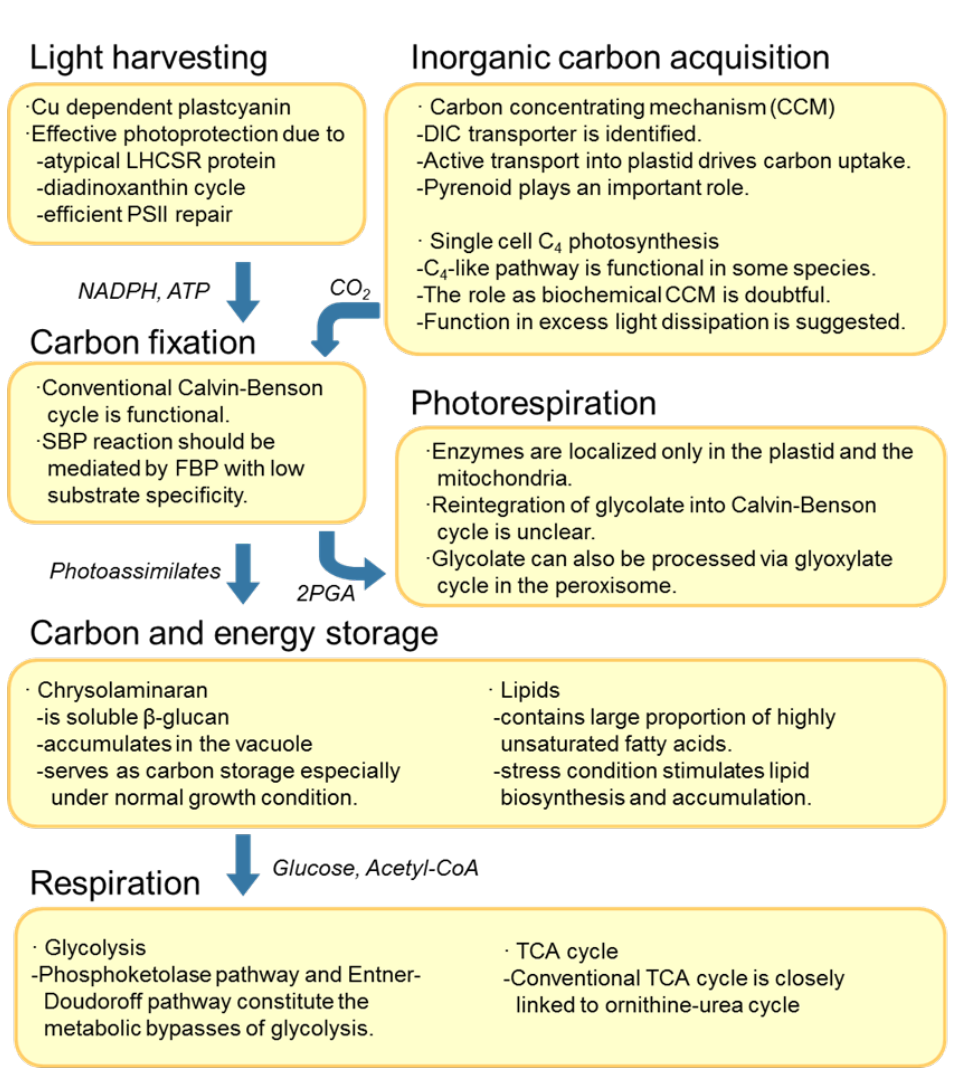
Figure 1. Summary of central carbon and energy metabolism in diatoms. DIC, dissolved inorganic carbon; LHCSR, light harvesting complex stress related; PSII, photosystem II; SBP, sedoheptulose bisphosphatase; FBP, fructose bisphosphatase; 2PGA, 2-phosphoglycerate; TCA, tricarboxylic